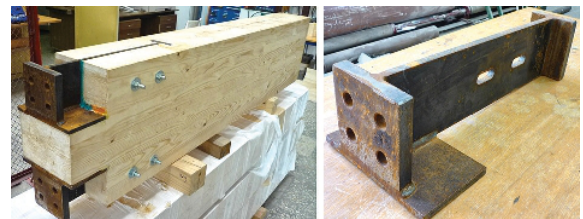
Fig. 3. Timber element with steel detail (left), steel detail